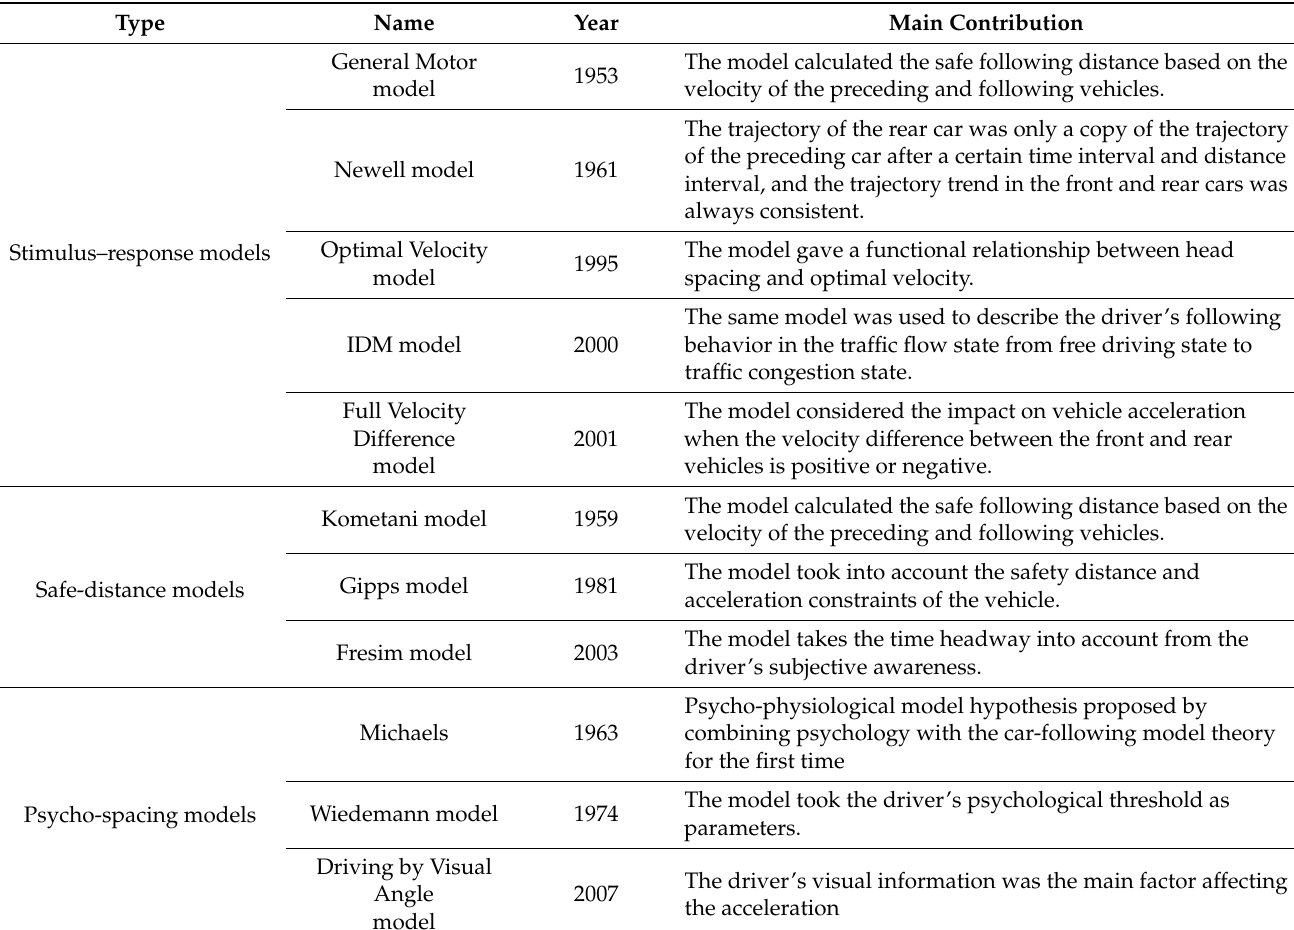
Table 1. Overview table of the main car-following